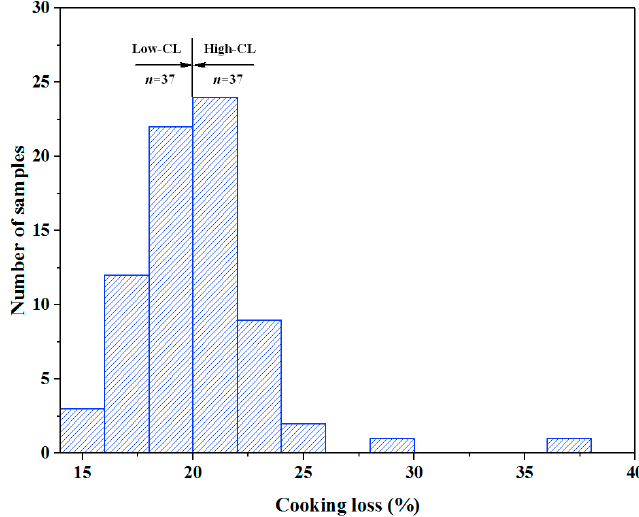
Figure 3. Sample distribution of 74 fillets based on mean CL values.